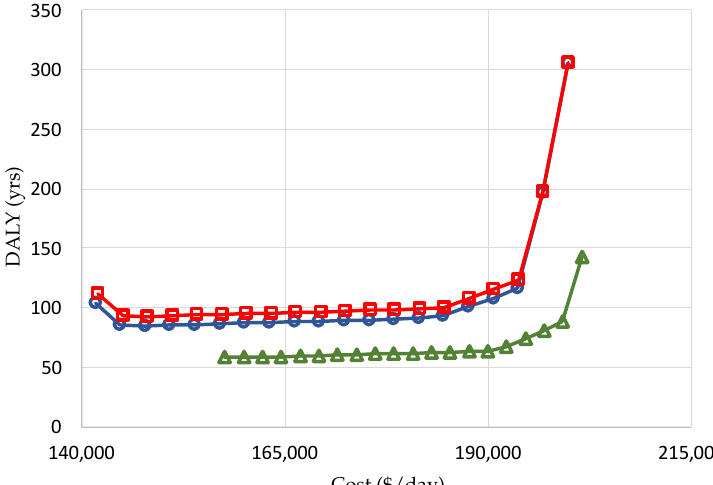
Figure 10. Cost vs. DALY Pareto set for Scenario 1 (– ◦ – blue), Scenario 2 (– (cid:3) – red), and Scenario 3 (– (cid:52) –